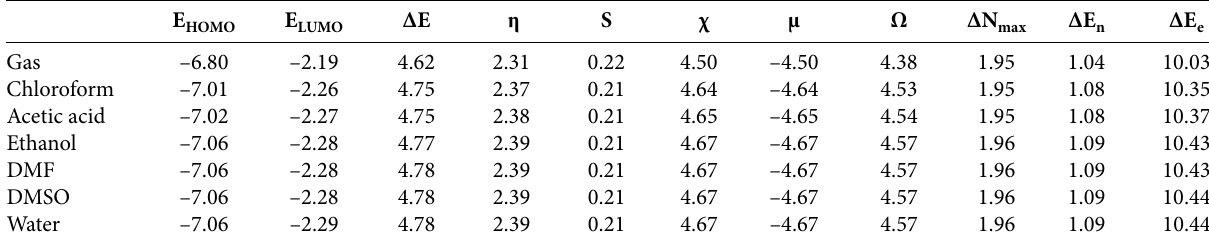
Table 1. Parameters related with E HOMO and E LUMO